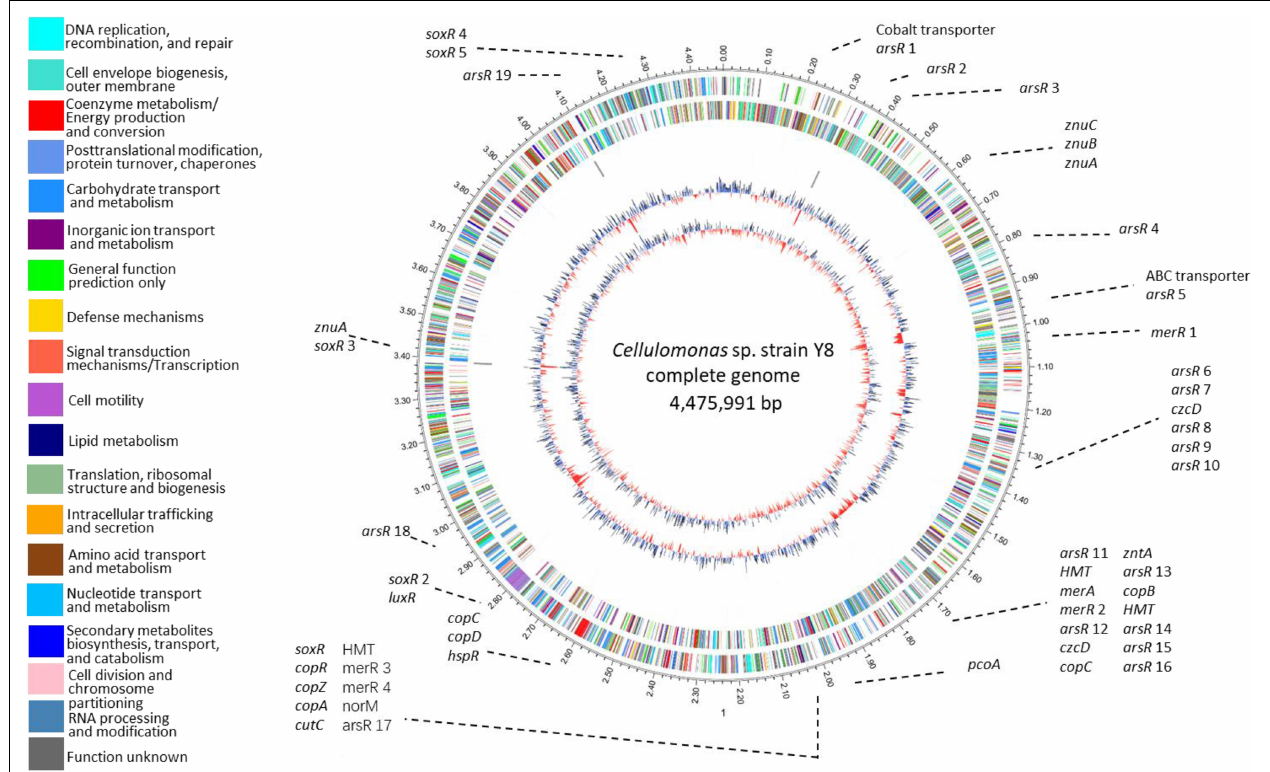
FIGURE 2 | Circular representation of Y8’s genome. Circles display from the inside outwards, (1) GC-skew (G-C/G+C ratio) using a 999 bp window; (2) GC-content using a 999 bp window; (3) ncRNA genes on the minus strand; (4) ncRNA genes on the plus strand; (5) COG assignments for predicted CDSs on the minus strand; (6) COG assignments for predicted CDSs on the plus strand; (7) scale in Mb.